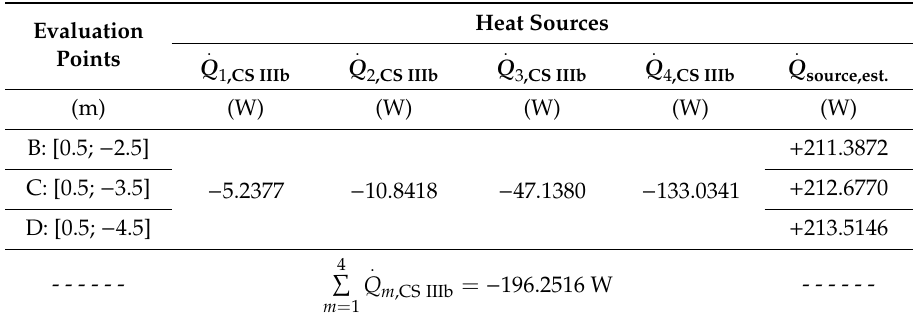
Table 12. Case study IIIb: 90% of the reference values of the negative heat sources . Q 3,CS IIIb and the nominal values of the heat sources and D.